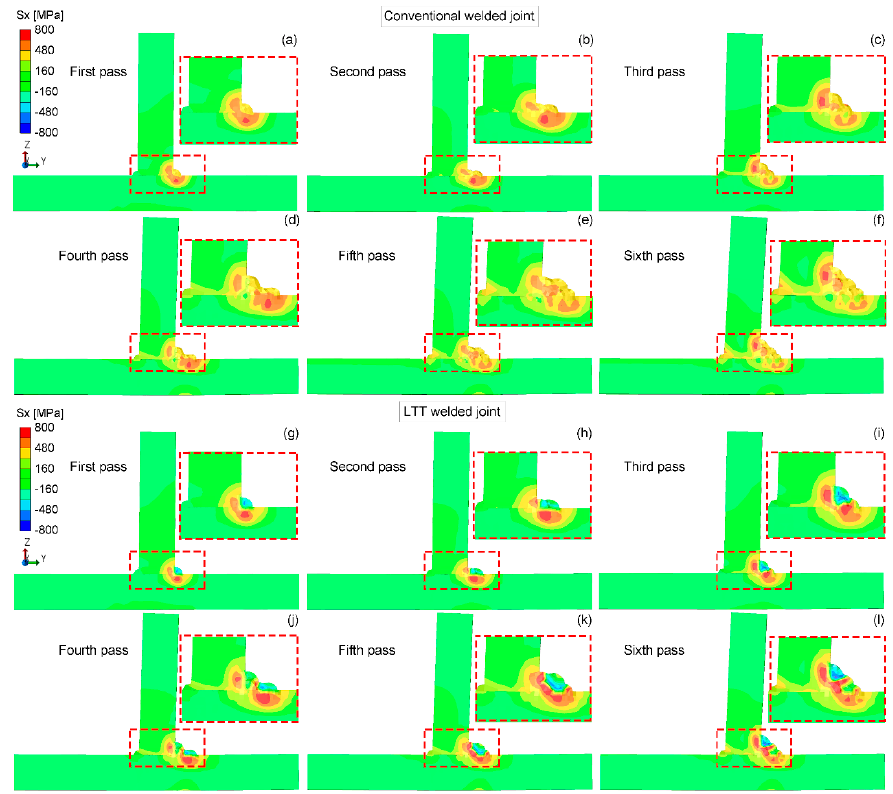
Figure 8. Residual Sx stress distribution in the mid-section of the conventional and LTT -welded joints: ( a , g ) first pass; ( b , h ) second pass; ( c , i ) third pass; ( d , j ) fourth pass; ( e , k ) fifth pass; ( f , l ) sixth pass.